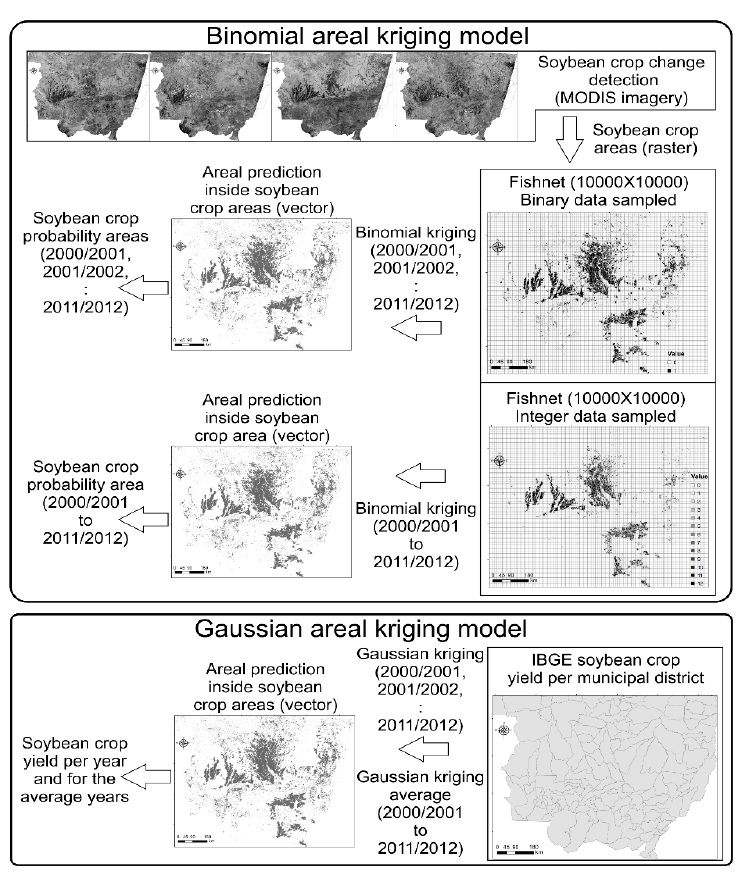
Figure 2. Scheme of binomial and Gaussian areal kriging implementation.